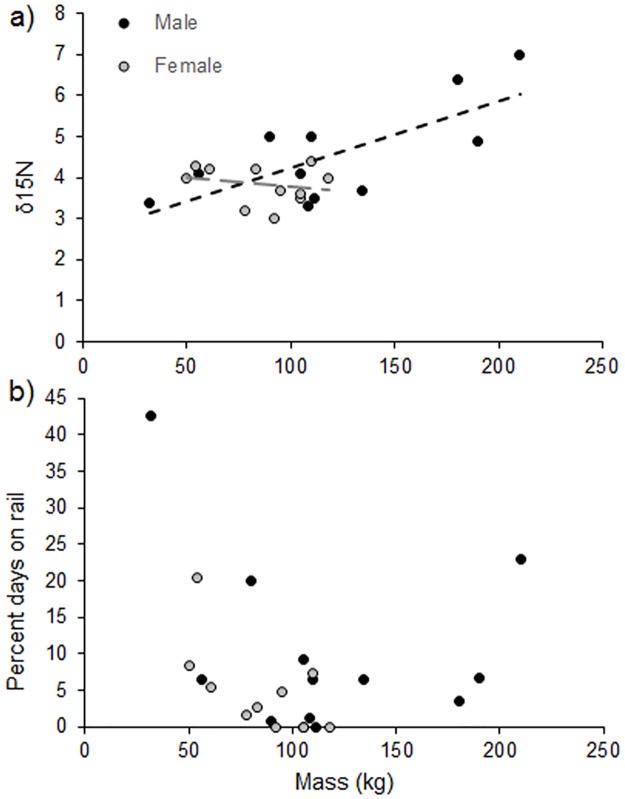
Bear mass and diet.Relationships between bear mass at time of capture and (a) δ15N values derived from bear hair, and (b) use of the rail for GPS-collared male and female grizzly bears in Banff National Park. Dashed lines indicate linear regression lines.